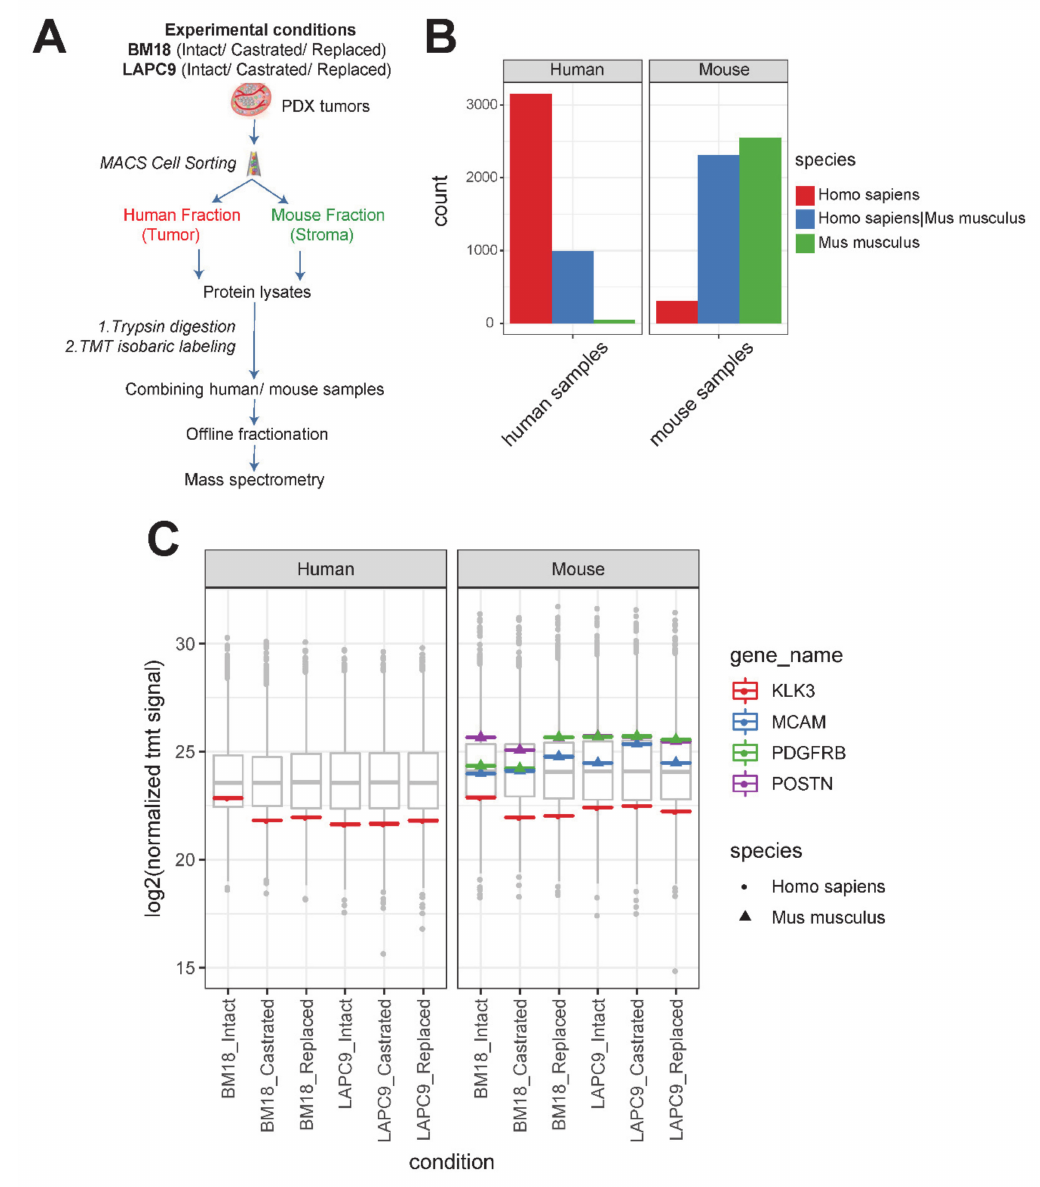
Figure 3. Proteomic analysis of human (tumor) versus mouse (stroma) of BM18 and LAPC9 tumors. ( A ) Experimental separation of human from mouse cell suspensions from fresh tumor isolations by MACS mouse depletion sorting. Cell fractions from intact / replaced ( n = 3 each), castrated ( n = 4) biological replicates were pooled into a single replicate ( n = 1) to achieve an adequate cell number for the proteomic analysis (1 × 10 6 cells). Protein lysates from the di ff erent fractions of BM18 / LAPC9 (intact, castrated and replaced) were subjected to Tandem Mass Tag (TMT) labeling (all-mouse or all-human samples were multiplexed in one TMT experiment each), followed by mass spectrometry. ( B ) Detected peptides from human and mouse fractions were searched against a combined human and mouse protein database. Number of species specific or shared proteins is indicated in di ff erent colors. ( C ) KLK3 (PSA; Prostate Serum Antigen) protein levels (log 2 normalized TMT signal sum values) in human cell isolations (left) and in mouse cell isolations (right), and the protein sequence was predicted as human-specific (spheres indicate Homo Sapiens sequence). Seven-up Ob-BMST signature markers POSTN, PDGFRB and MCAM protein levels were absent in human cell isolations (left) and present in mouse cell isolations (right), while all the protein sequences were mouse-specific (triangles indicate Mus Musculus